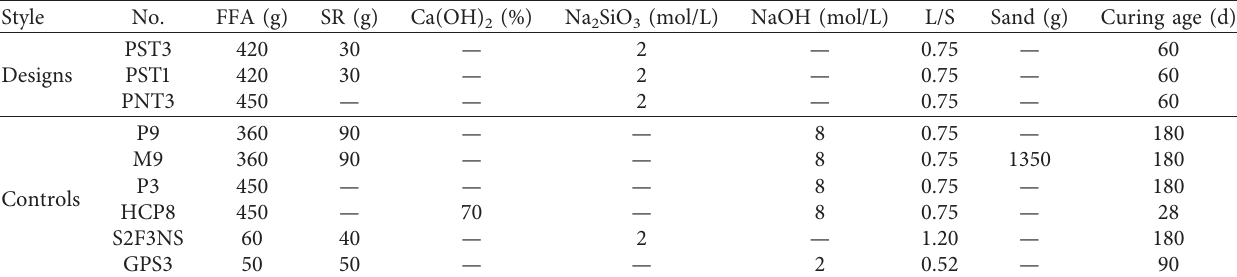
Table 5: The designed samples and controls for AAFCs detected through characterization